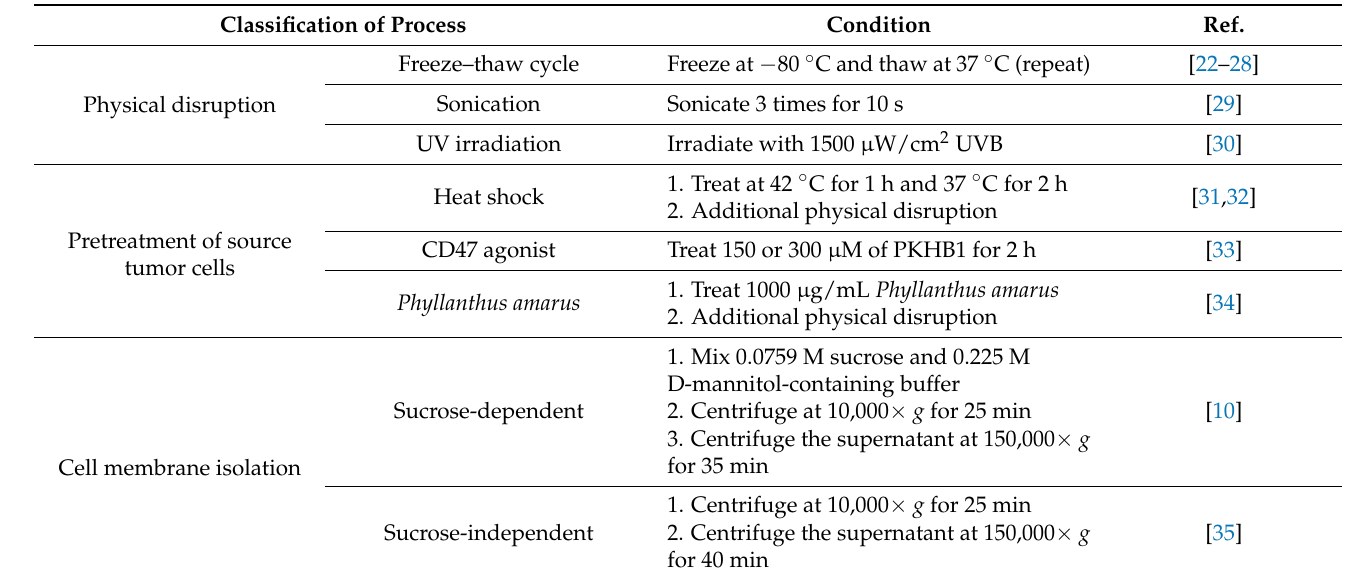
Figure 2. Schematic illustration of preparation of TCLs via various conditions. ( A ) Repeated freeze– thaw cycle could induce necrosis of tumor cells and release immunogenetic molecules (e.g., DAMPs, TAAs), ( B ) sonication generates nano-sized fragments, average particle size as measured by Nano Sight, ( C ) UV irradiation for facilitated cellular uptake, ( D ) heat shock evokes release of HSP70 in tumor cells, ( E ) oxidation rapidly induces tumor cell death and generates advantageous immunogenic molecules, ( F ) PKHB1 peptide-derived TSP-1 interacts with CD47 and activates the atypical caspase-independent and calcium-dependent signaling in cell death. ( B ) and ( F ) are reproduced with permission from Refs. [29,33,36] .